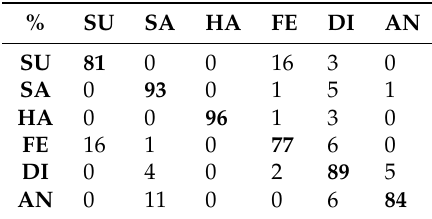
Table 13. Confusion matrix: 47